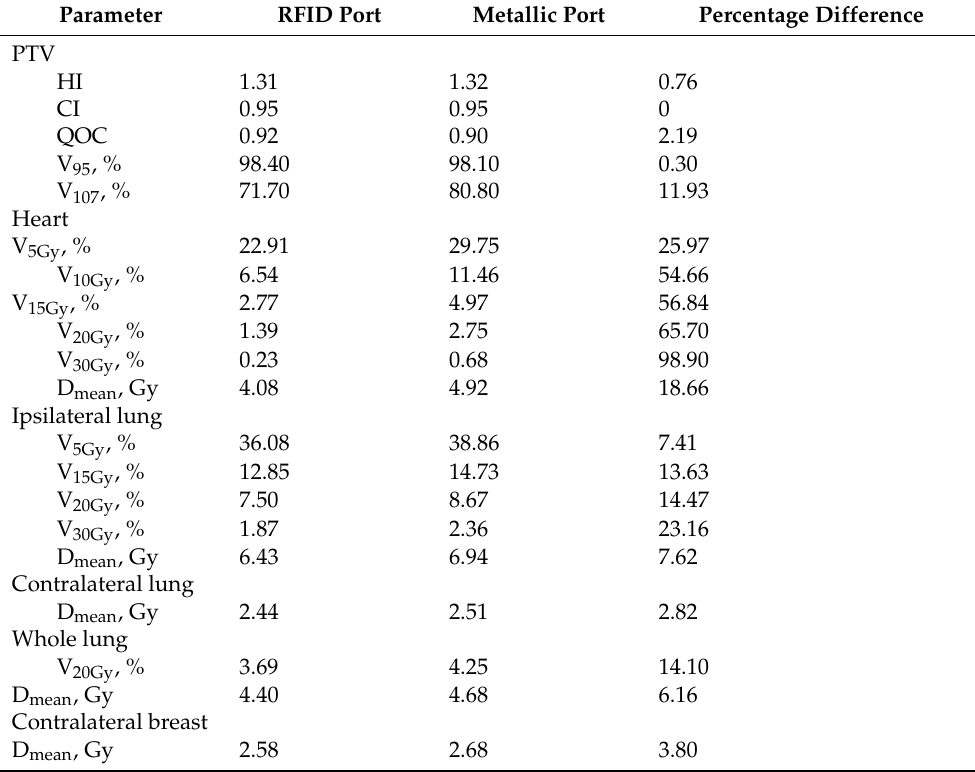
Table 3. Assessment of plan quality.